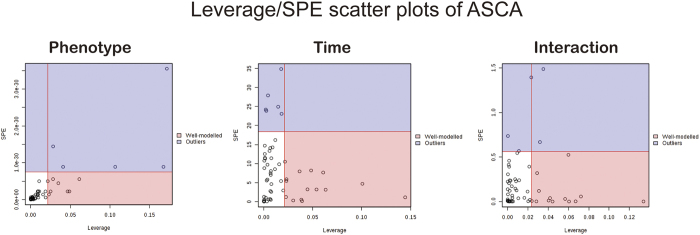
Leverage/SPE scatter plots of the ASCA variables submodels for phenotype, time and their interactions.Metabolites in red have high loadings that follow the expression patterns of the submodels. Metabolites in blue have expression patterns that are different from the major patterns.